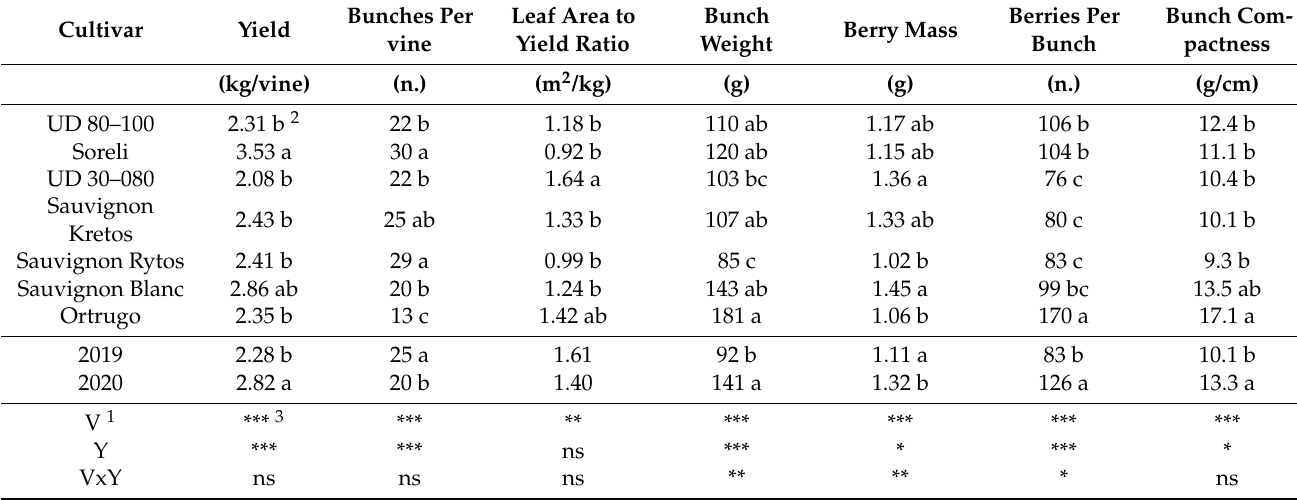
Table 3. Yield, vine balance, and bunch morphology of five pathogen-resistant grapevine genotypes and two non-resistant Vitis vinifera cultivars in 2019 and 2020. Berries Per Bunch Com- Bunches Per Leaf Area to Bunch Berry Mass Cultivar Yield Bunch pactness vine Yield Ratio Weight (kg/vine) (n.) (m 2 /kg) (g) (g) (n.) (g/cm) UD 80–100 Soreli